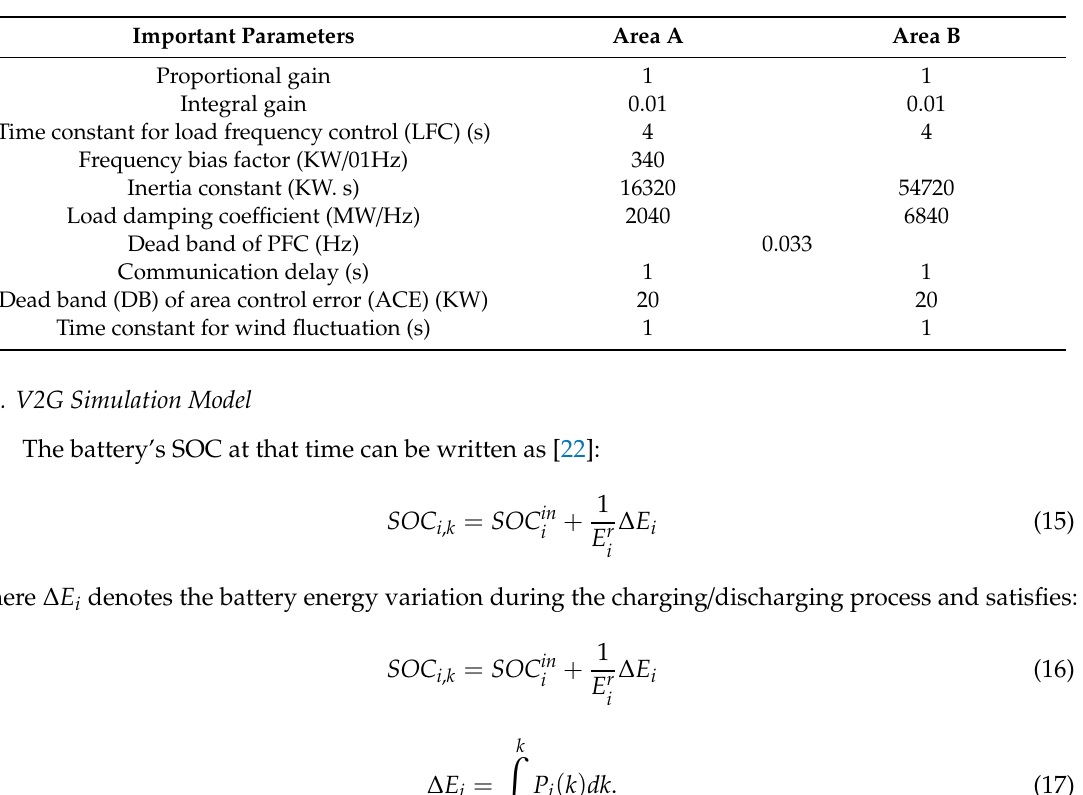
Table 2. Two-area interconnected power grid.